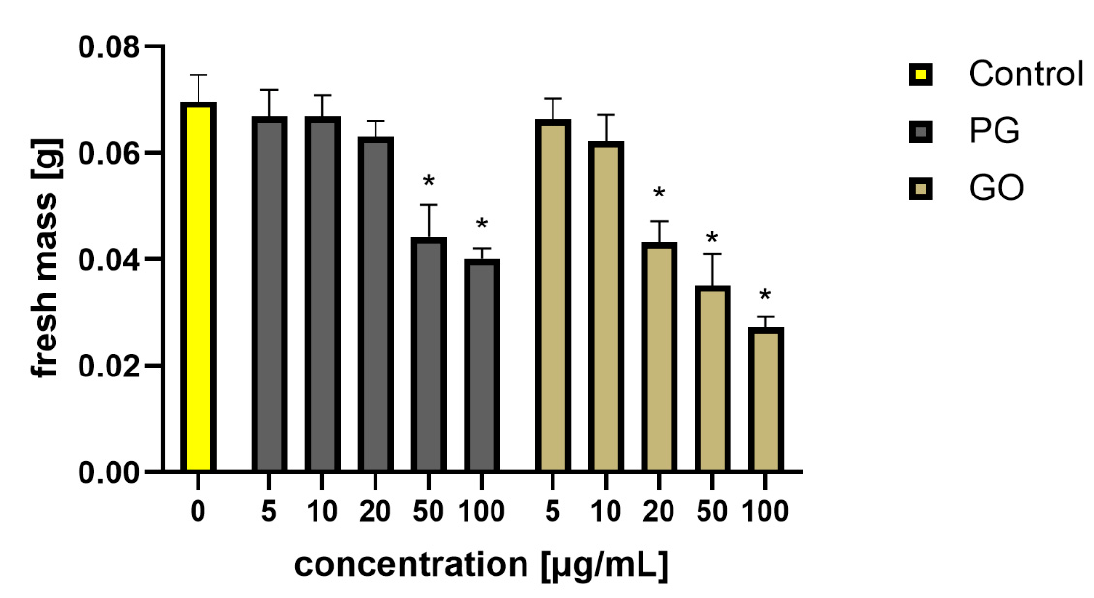
Figure 5. Average fresh mass of Lemna minor (10 plants per measurement) after PG and GO treat- ment. Values in the rows marked with an asterisk show statistically significant differences ( p < 0.05) as compared to the control assay. Abbreviations: C—control group (untreated cells); PG—pristine graphene; GO—graphene oxide.